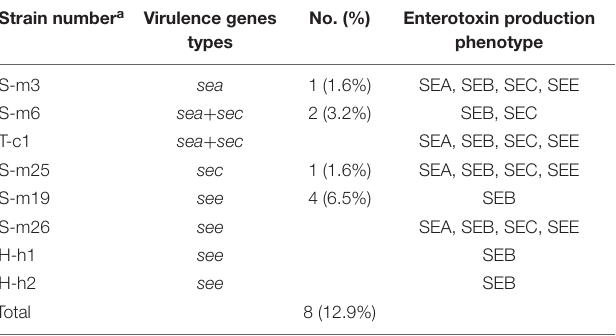
TABLE 3 | Toxin-gene profiles of enterotoxigenic S. aureus isolates from raw